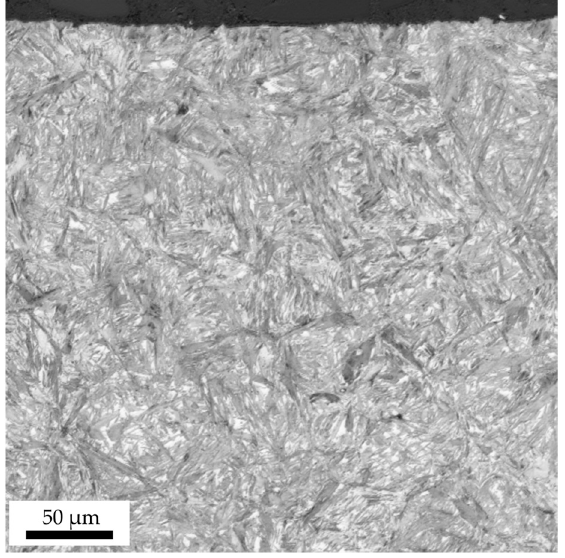
Figure 3. Microstructure after vacuum carburizing quenching and tempering near the surface. As an artificial surface defect, a semicircular slit was induced on the surface of the specimen by electric discharge machining to simulate an initial crack-like surface defect. Figure 4 depicts the shape and dimensions of the surface slit. The semicircular slit depths were 0.15, 0.20, and 0.30 mm.